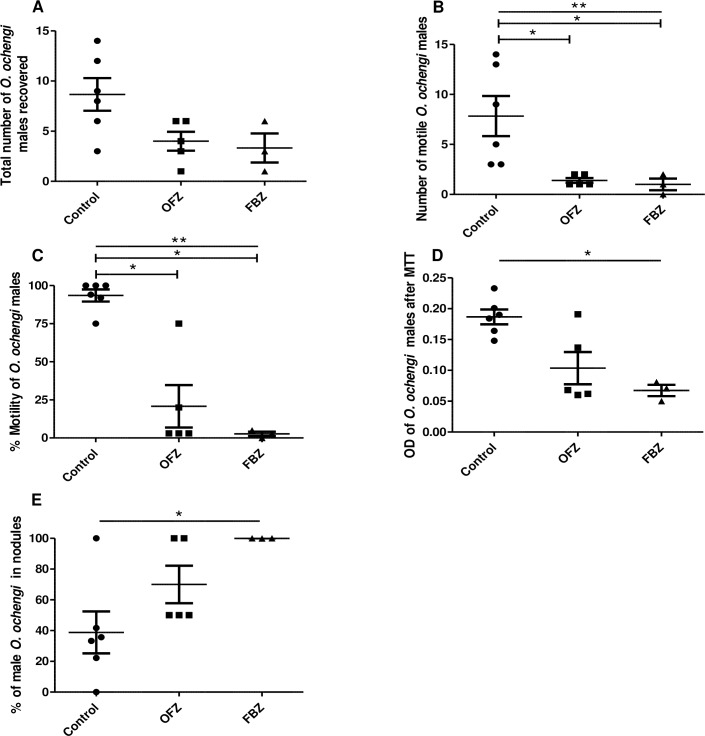
Oxfendazole (OFZ) decreases the number of O. ochengi motile male worms and their viability.Gerbils were implanted with 20 O. ochengi male worms and treated for 5 days starting on day 3 post-implantation subcutaneously with 12 mg/kg OFZ, BID, or with 10 mg/kg FBZ, SID. Animals were sacrificed on day 35 post-implantation. A) Total number of male worms recovered, B) Number of viable male worms recovered, C) Percent motility of the male worms recovered, D) OD of DMSO treated male worms after MTT staining, and E) Percent of O. ochengi male worms within the nodules. FBZ was used as positive control. N = 3–6 per group. Statistical significance between groups was done using Kruskal-Wallis Test with Dunn’s multiple comparison. *p <0.05; **p <0.01.